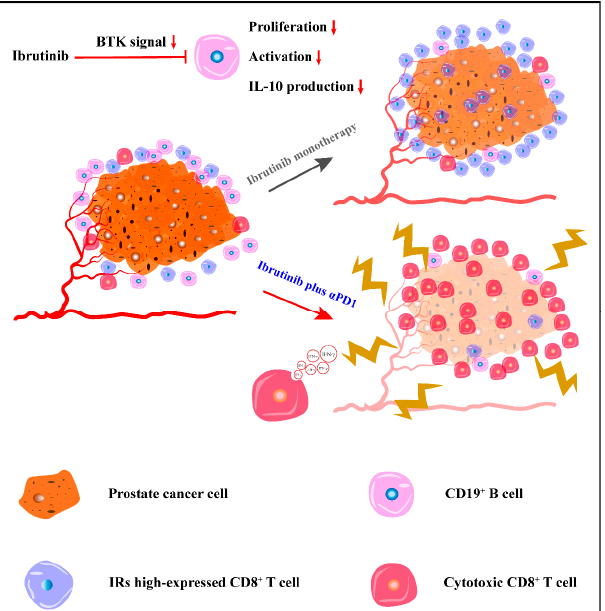
Figure 8. Conceptual graph. Ibrutinib monotherapy fails to suppress mouse metastatic PCa growth but inhibits B cell proliferation, activation, and IL-10 production, leading to the augmentation of CD8 + T cells highly expressing IRs through the BTK signaling. Ibrutinib synergizes with anti-PD-1 immunotherapy, elicits an enhanced cytotoxic response of CD8 + T cells, and achieves great control of mouse metastatic PCa. BTK, Bruton’s tyrosine kinase; IRs, inhibitory receptors; PCa, prostate